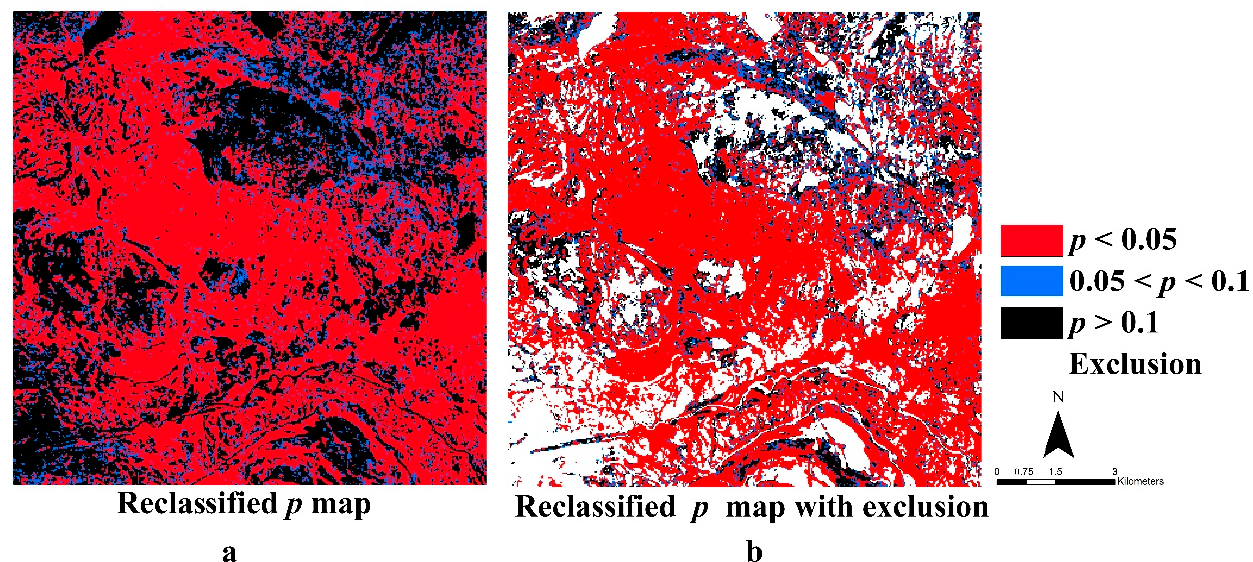
Figure 5. Reclassified p -value map without exclusion and with exclusion.